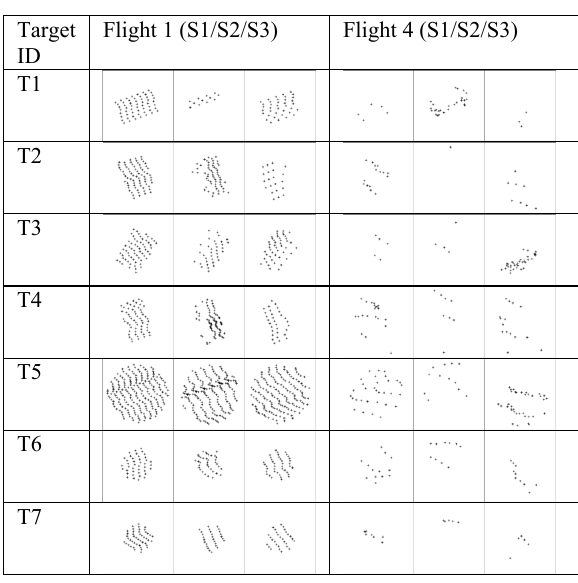
Table 4. Returns from all Targets per Strip for Flights 1 and 4